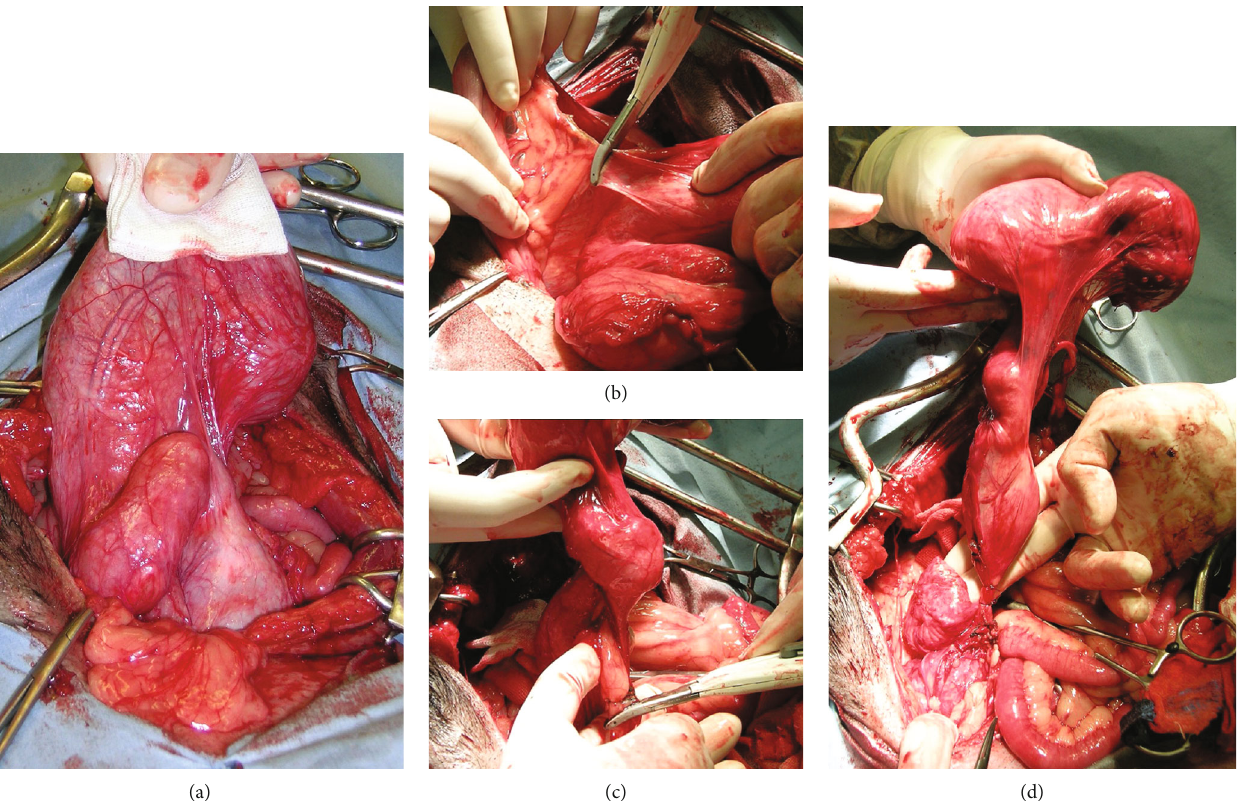
Figure 4: Stages of surgery: (a) ventral midline celiotomy and exploration of part of the large, fl uctuating, convolute structure occupying a large portion of the abdomen; (b) dissection of peritoneal anchors to isolate the complex of megaureter, renal pelvis, residue of the kidney, vas deferens , and sketch of the genital annexes; (c) sealing of the vascular supply; (d) ligatures of the distal portion of the ectopic ureter and vas deferens in proximity to the prostate gland to ful fi ll the nephroureterectomy and